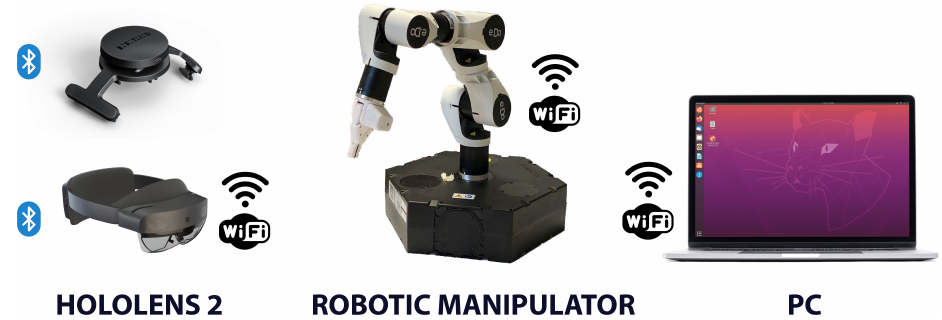
Figure 2. Hardware architecture of the proposed solution.